Question: Provide a one-line summary of what is displayed.
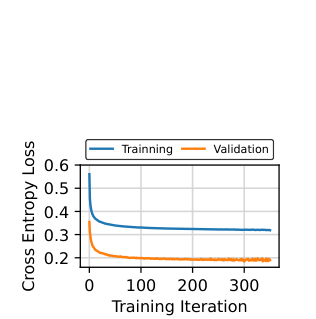
Answer: NN Classifier Cross Entropy Loss.